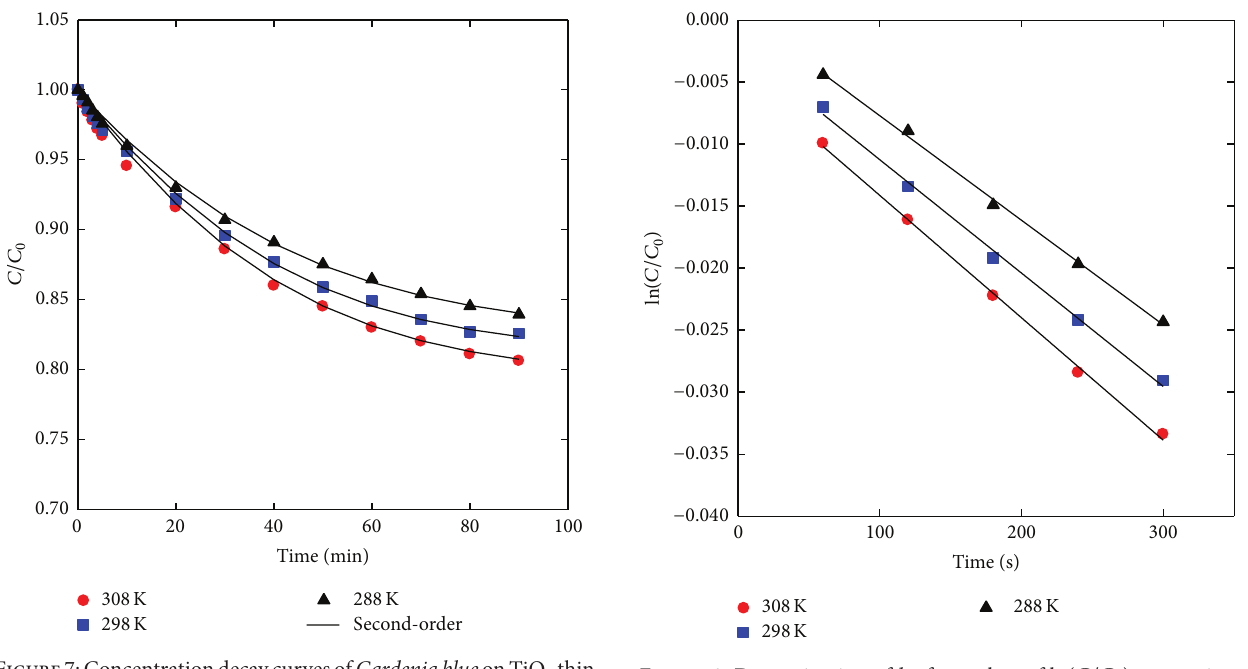
Figure7:Concentrationdecaycurvesof Gardeniablue onTiO 2 thin Figure 8: Determination of 𝑘 𝑓 from plots of ln (𝐶/𝐶 0 ) versus time film. for Gardenia blue on TiO 2 thin film. Figure 10. The I-V curves were used to calculate the short- ), open-circuit voltage ( 𝑉 ), fill factor circuit current ( 𝐼 sc oc ) of the DSSCs. (FF), and overall conversion efficiency ( 𝜂 eff